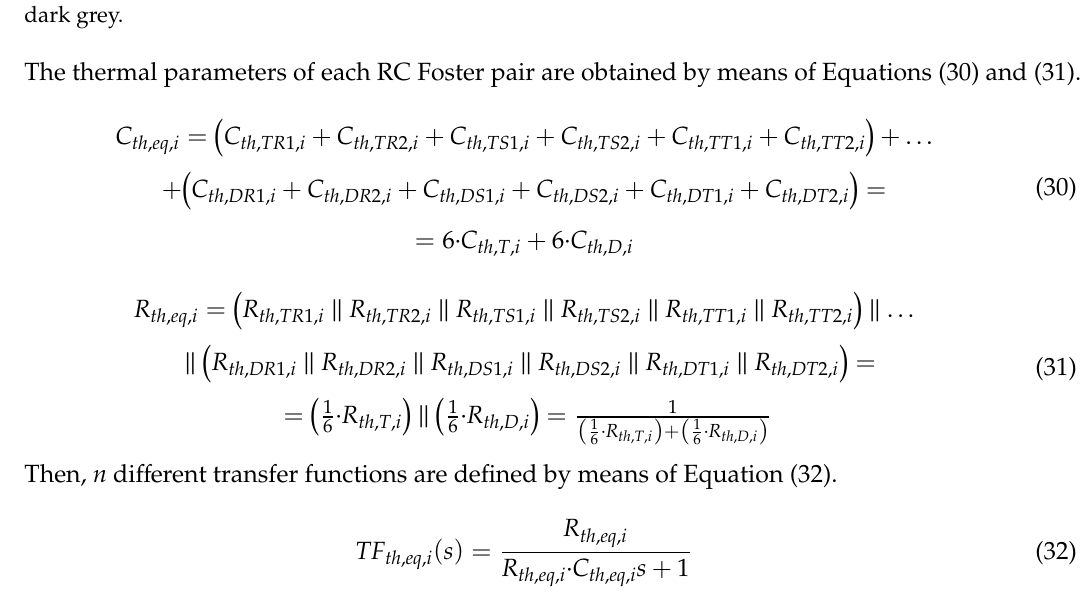
Figure 20. 12 × n RC to 1 × n RC simplification. Each semiconductor’s thermal model is shaded in Figure 20. 12x n RC to 1x n RC simplification. Each semiconductor’s thermal model is shaded in dark dark grey.